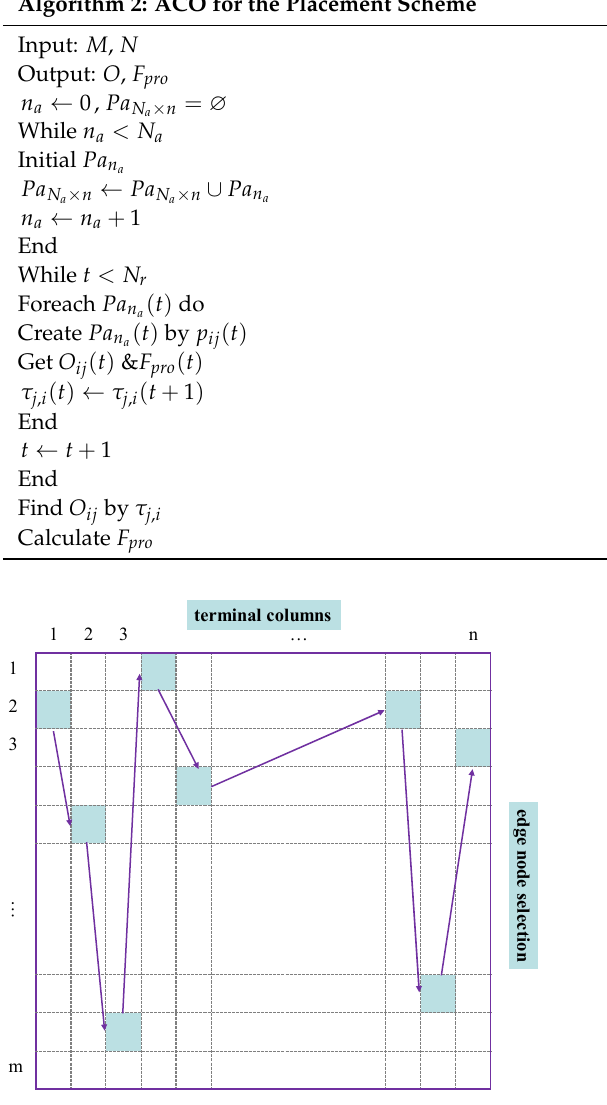
Figure 4. One search path grid of ACO.